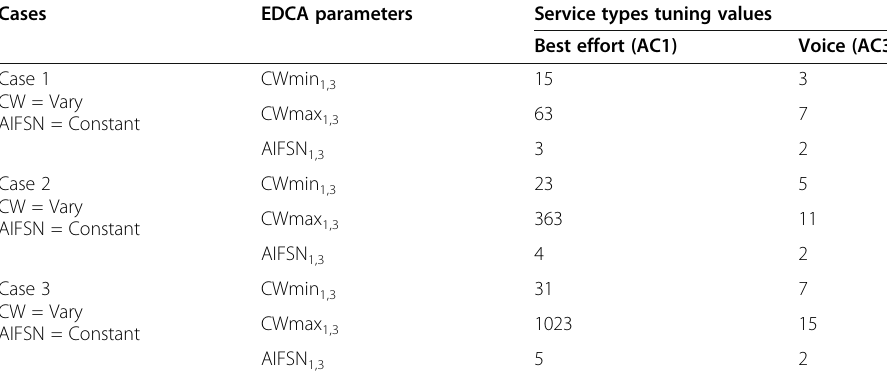
Table 5 The CW tuning numbers at a fixed AIFSN